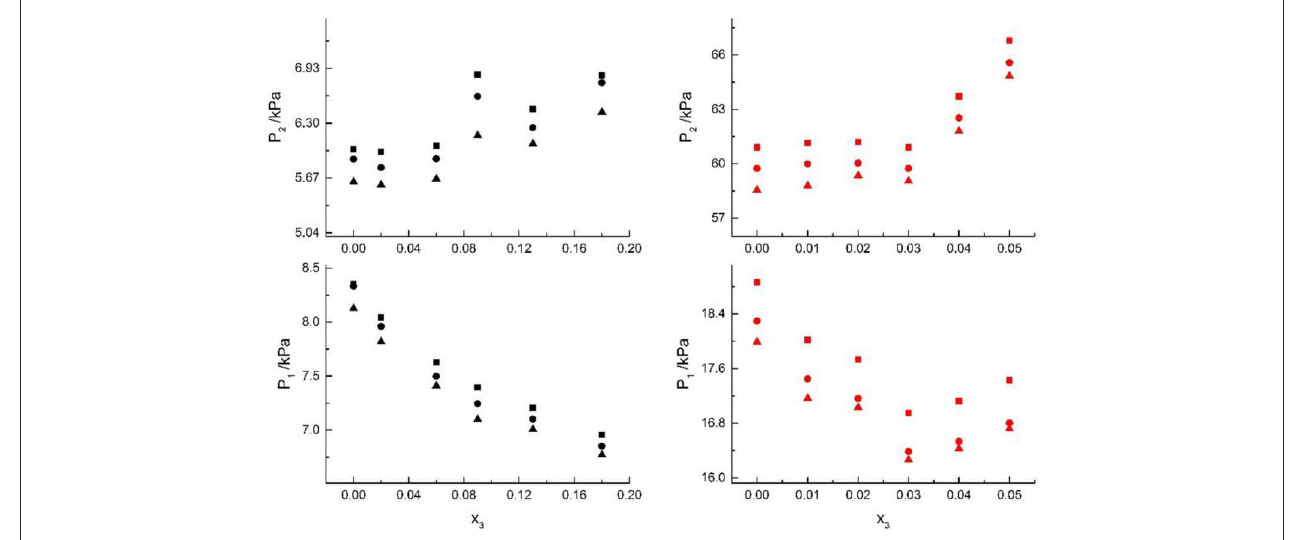
FIGURE 2 | VLE of H2O (1) + CH3OH (2) + NaCl (3): (cid:4) indicates the Literature data (Yang and Lee, 1998); H2O (1) + CH3OH (2) + NaBr (3): • indicates the Literature data ( Xu et al., 2018); H2O(1) + CH3OH(2) + NaI(3): N . Filled symbols (Black: x2 = 0.08 and T = 316K; Red: x2 = 0.46 and T = 341K) indicate the experimental data.